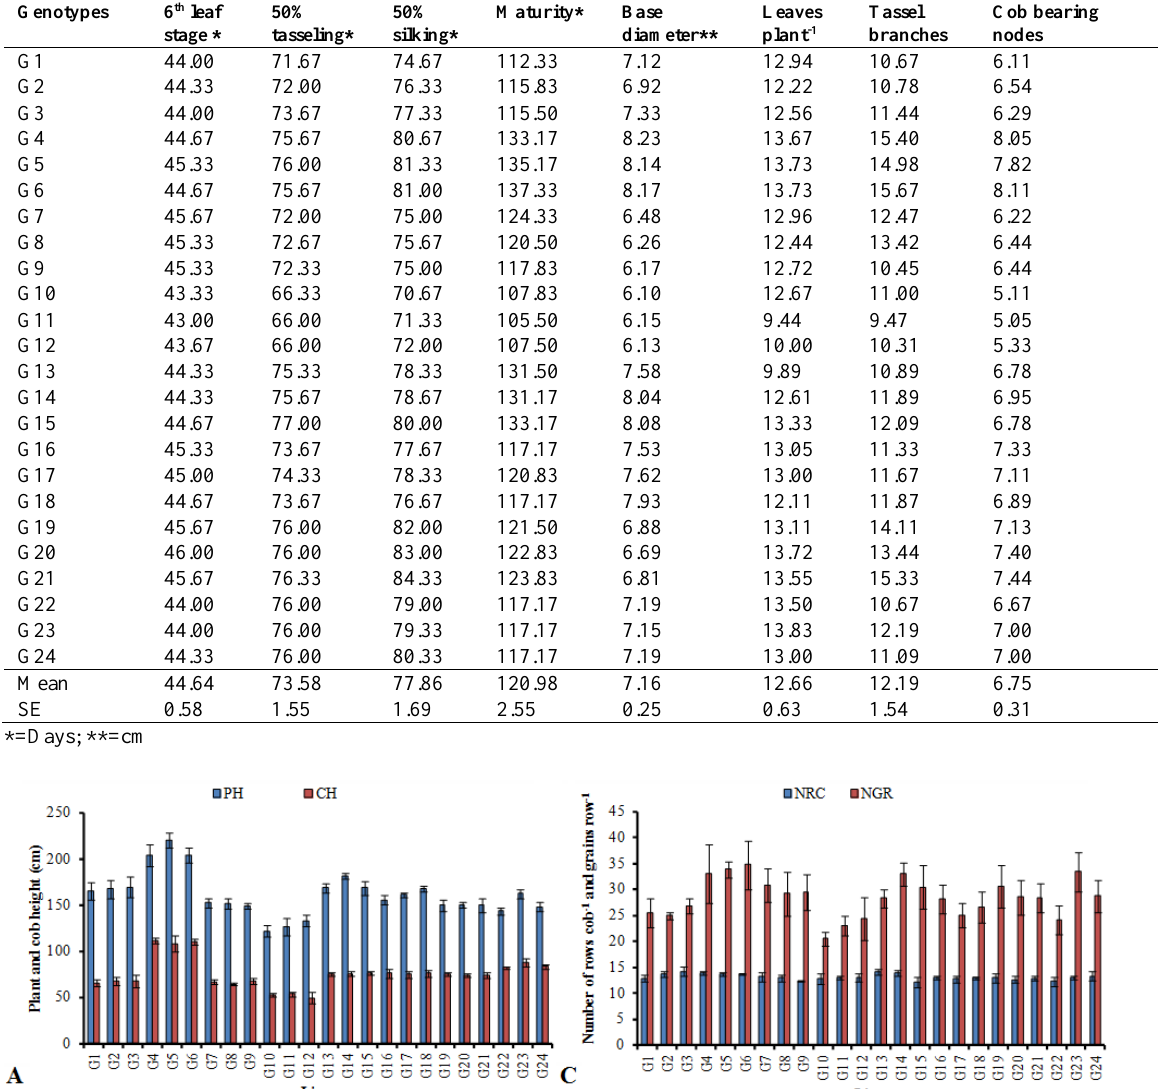
Table 2. Mean performance over three replications of different growth parameters of twenty-four F 3 populations of white maize Genotypes